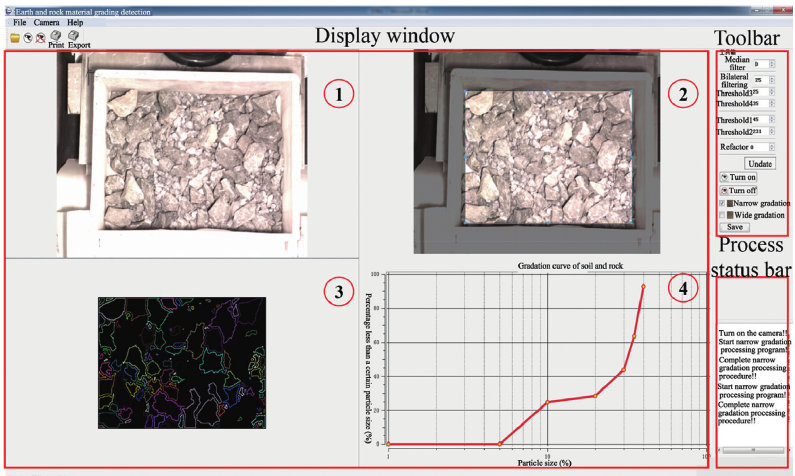
Figure 4: Software interface of the gradation detection system.